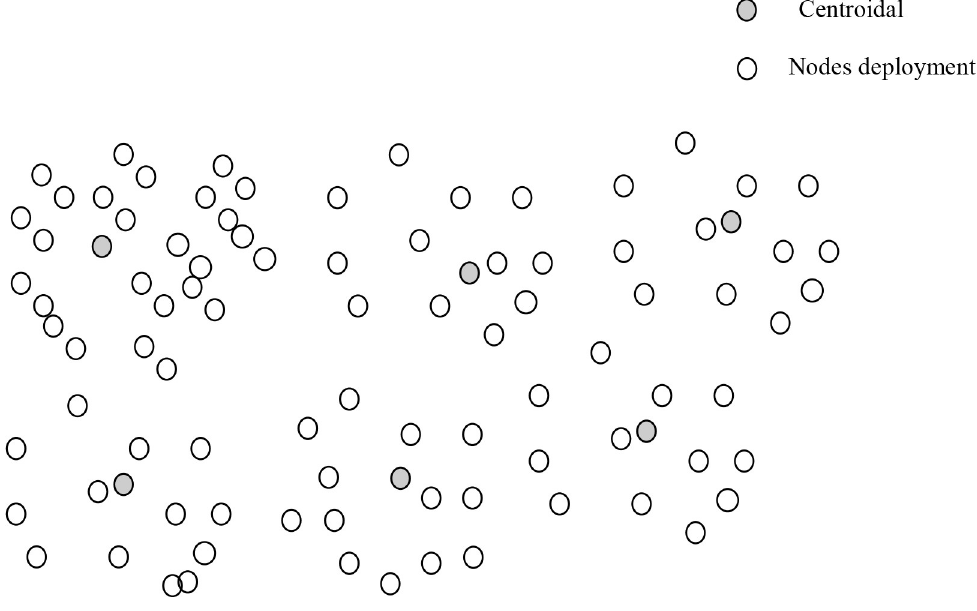
Fig 2. Clusters formation.